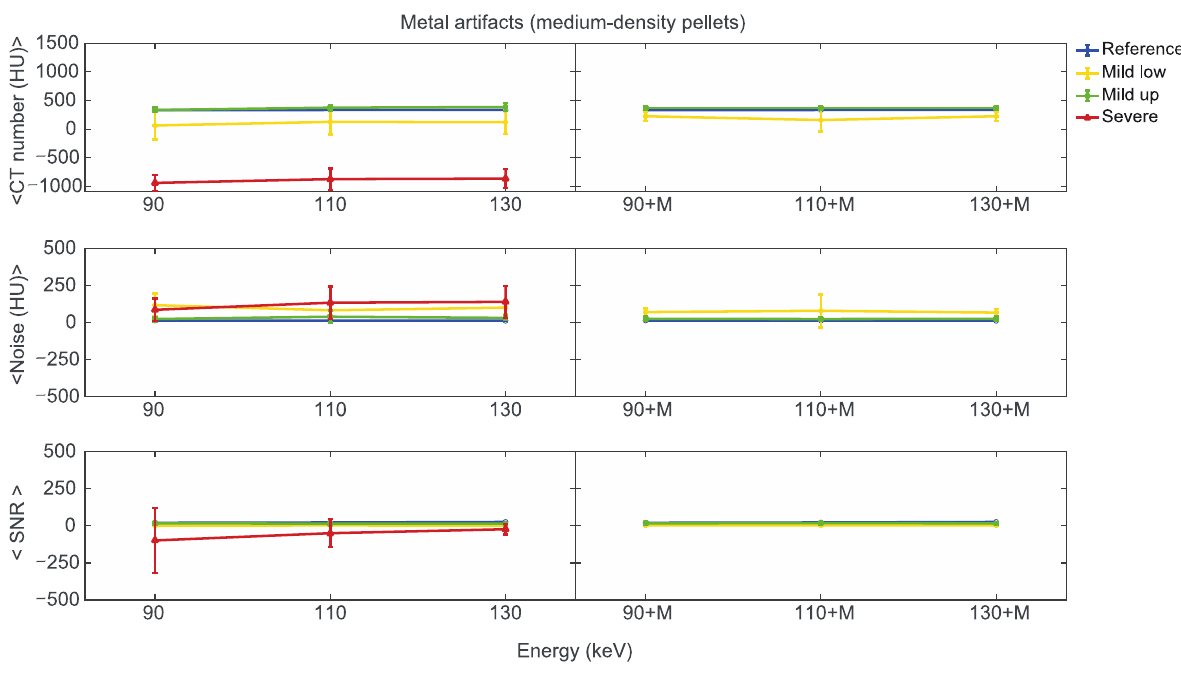
Figure 8. Mean CT number, noise, and SNR for medium-density pellets of classified artifacts as a function of the reconstructed images, i.e., VMI without (90, 110, 130) and with the MARS algorithm (90+M, 110+M, and 130+M). The values for mild low, mild up, and severe artifact are reported with yellow, green, and red lines, respectively. The reference values are indicated with a blue line.